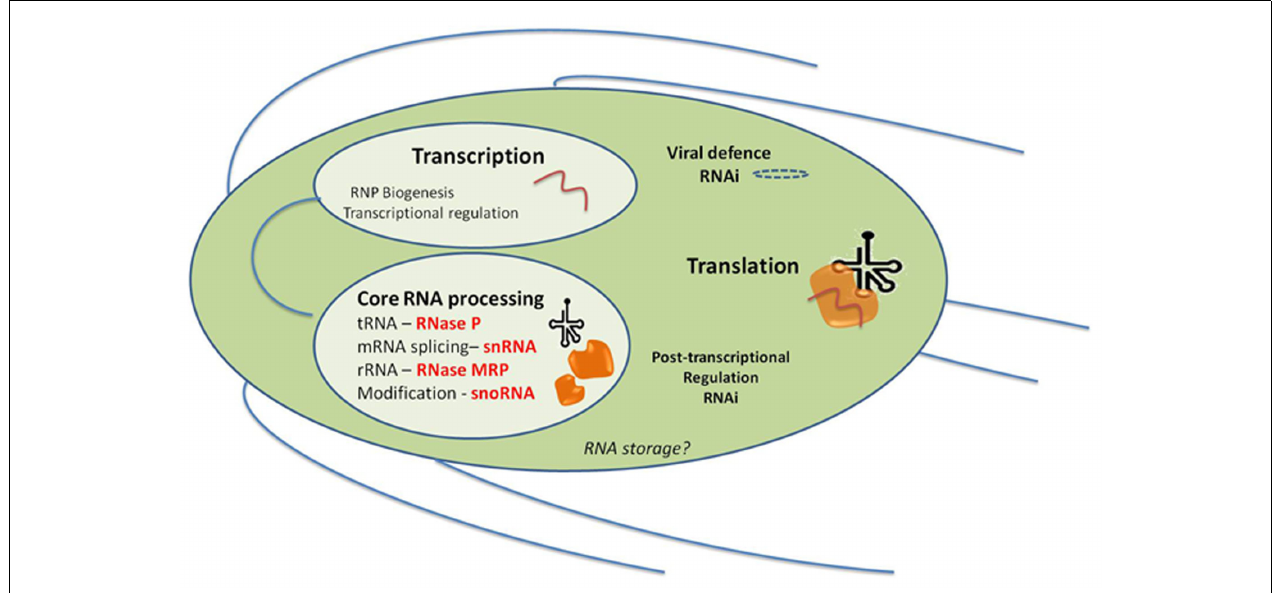
found in both nuclei. RNAi may also be important in viral defense since some siRNAs found in high-throughput sequencing do map to the stable Giardiavirus (unpublished results). It is not known yet whether Giardia has RNA storage granules but their presence in Trypanosoma does not preclude them here. A similar diagram can be visualized for Trichomonas except that it only has one